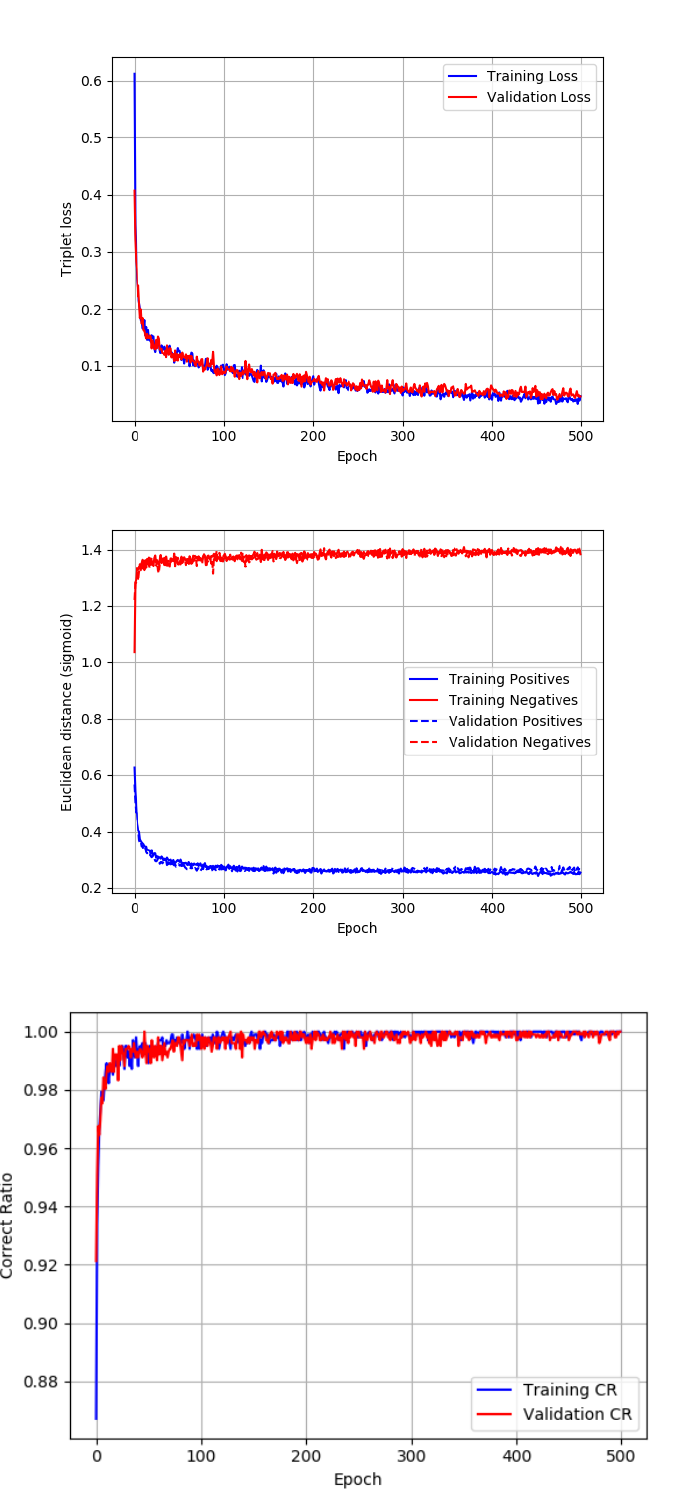
Figure 6. Training process for the IR